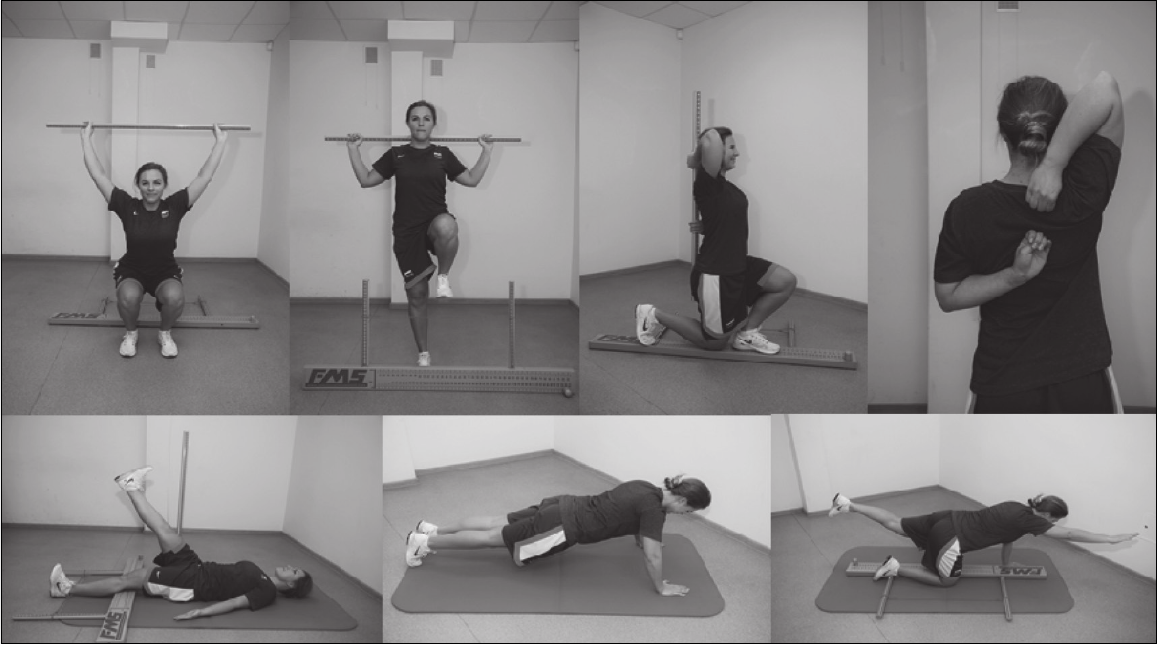
Figure 2. Functional Movement Screen (FMS TM ) tests: deep squat, hurdle step, in-line lunge, shoulder mobility, active straight leg rise, push-up and rotary